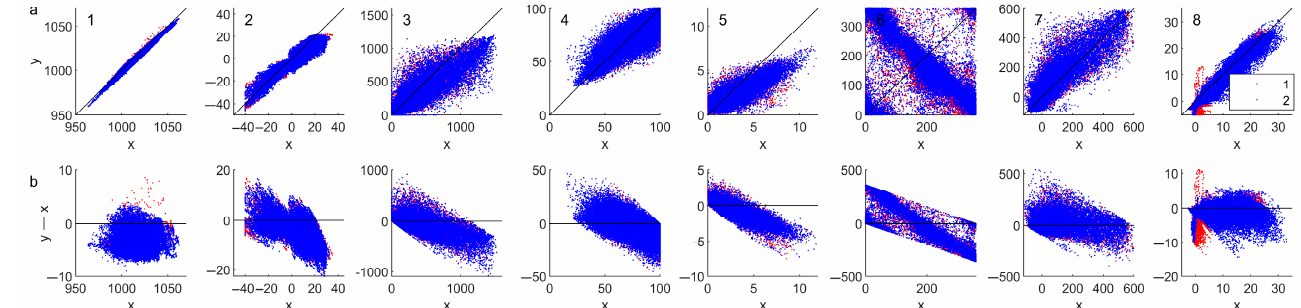
Figure 3. The results of direct comparison meteorological variables from observations (y) and ERA5-Land reanalysis (x). 1—air surface pressure (hPa), 2—air temperature (°C), 3—incoming photosynthetically active radiation (µmol/m 2 /s), 4—relative air humidity (%), 5—wind speed (m/s), 6—wind direction (deg), 7—net radiation (W/m 2 ), 8—soil temperature at 5 cm (°C) ; blue—training subset; red—validation subset, ( a ) observed (y) vs. ERA5-Land data (x), ( b ) error (y − x) vs. ERA5-Land data (x).